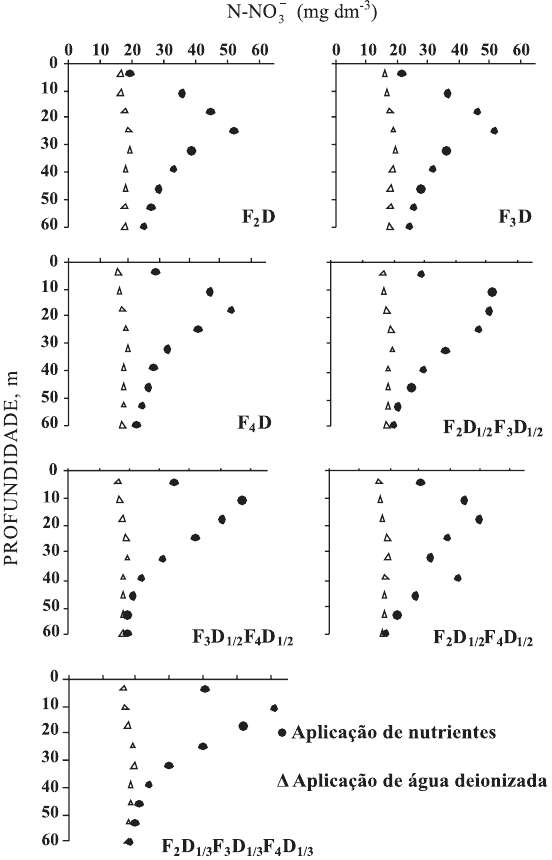
Figura 2. Teores de nitrato ao longo de colunas com amostras do LVdf, considerando a fração da lâmina de irrigação (F) em que o nutriente foi aplicado em dose integral (D) ou fracionado em ) ou em três vezes (D duas (D 1/2 1/3